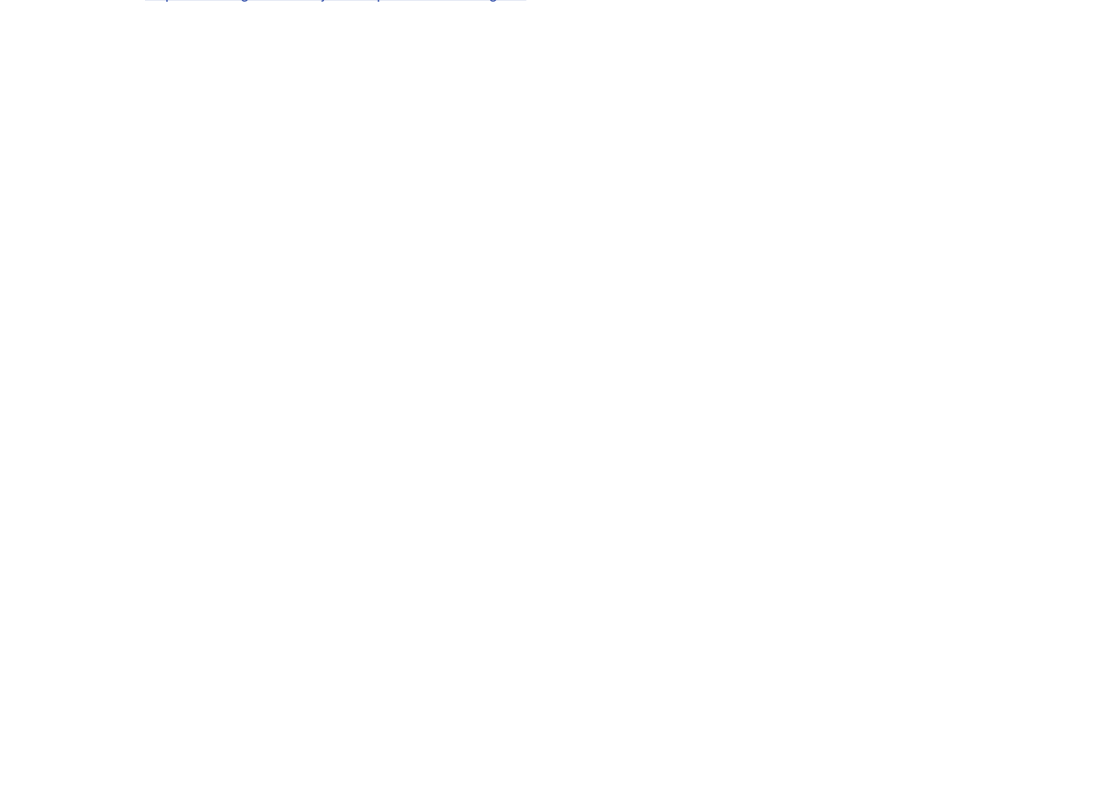
Fig 2. Conceptual framework explaining the relationship between various determinants and length of hospital stay after childbirth (LoS).